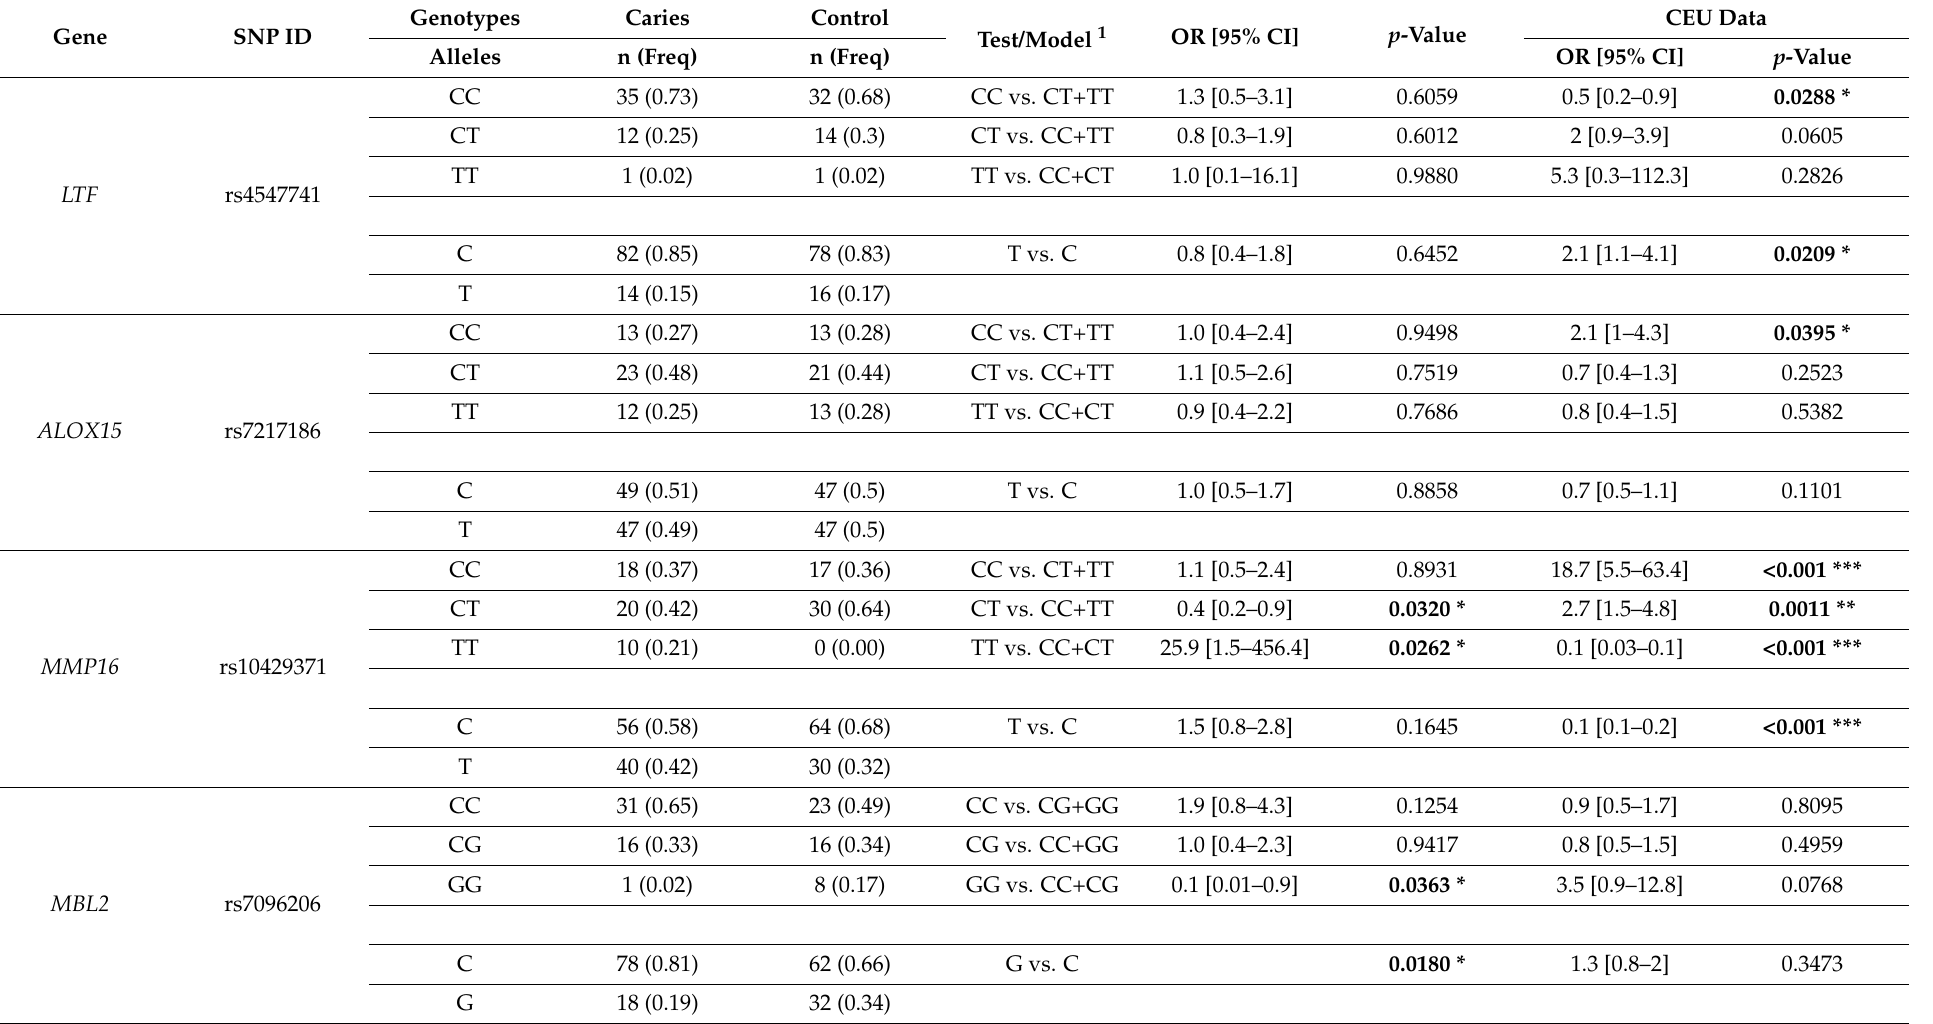
Table 3. Genotype and alleles distribution differences for 6 SNPs genotyped in this study between study subgroups (caries vs. caries-free) and between our cohort and CUE data.